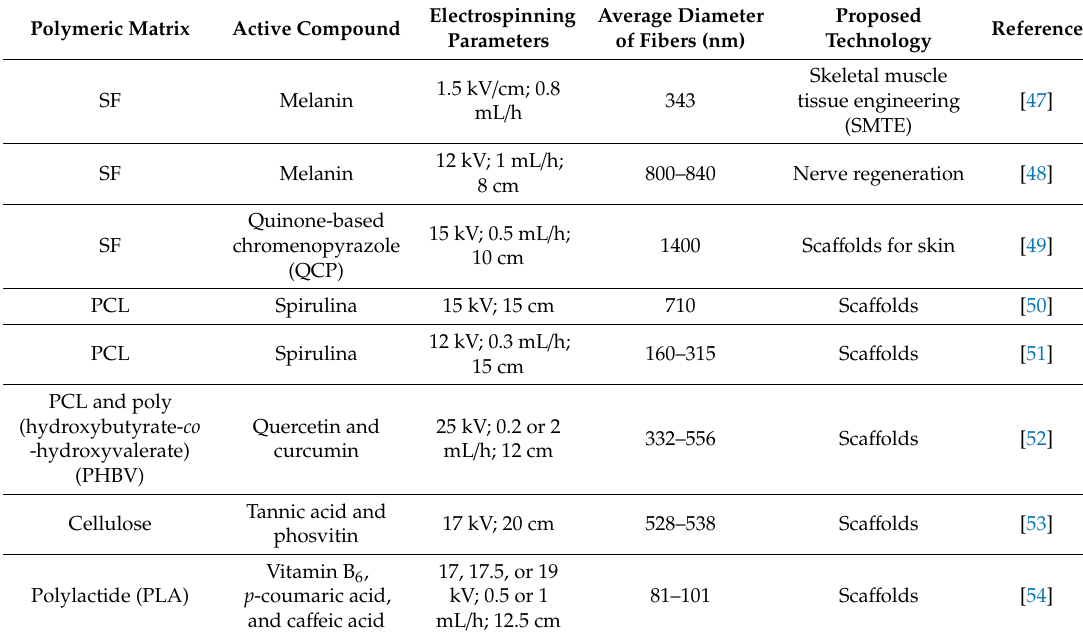
Table 3. Characteristics of antioxidant nanofibers with proposed applications in tissue engineering from eight reviewed